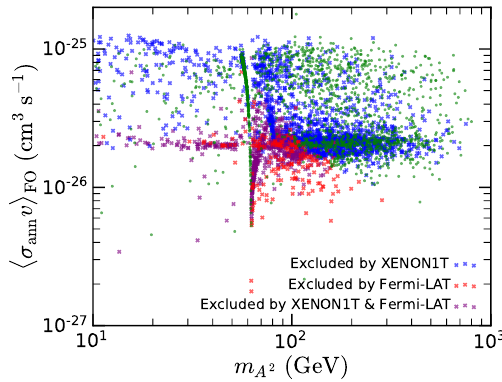
Figure 1. Parameter points predicting the observed DM relic density projected in the m h σ ann v i FO plane. The blue and red points are excluded by the XENON1T direct detection exper- iment and the Fermi-LAT indirect detection experiment, respectively, while the purple points are excluded by both. The green points survive from both constraints. The details will be described in subsection